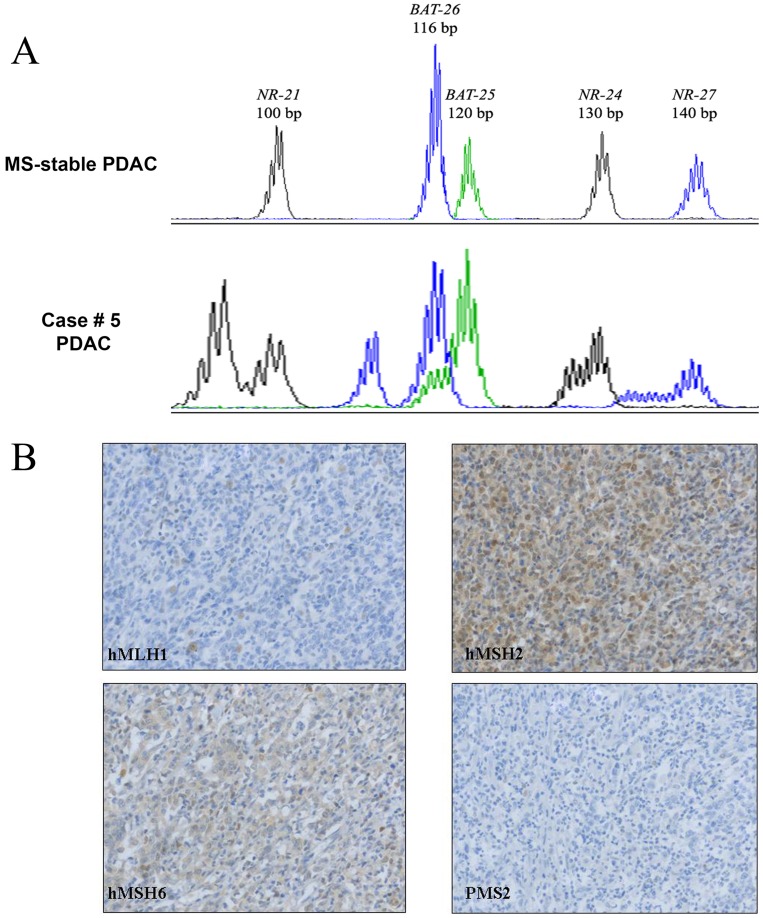
Electropherograms of the analysis of mononucleotide microsatellite markers BAT26, BAT25, NR-21, Nr-24 and NR-27 in pancreatic cancers.From top to bottom, an example of MS-Stable PDAC, and the only MSI PDAC (Case # 5) (Panel A). Immunohistochemical analysis of MMR protein expression in the medullary hMLH1-deficient PDAC (Case #5), retaining hMSH2 and hMSH6 expression. Note the loss of PMS2, due to protein degradation in the absence of the cognate partner hMLH1 (Objective magnification, 10×) (Panel B).